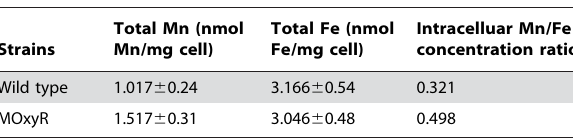
Table 3. Intracelluar Mn and Fe levels in wild type and